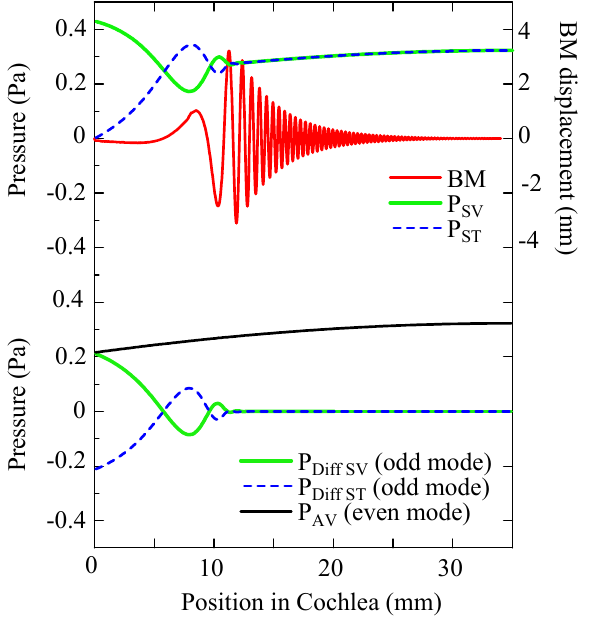
Figure 4. The upper graphs show the sound pressure levels (SPLs) in the SV ( P SV in green) and ST ( P ST in blue) and the displacement of the BM (BM in red) when a 1 Pa, 5000 Hz pure tone is applied to the OW. The lower graphs present the SPLs of the even symmetric sound mode ( P AV in black) in the SV and ST, and odd symmetric sound mode in the SV ( P Diff_SV in green) and ST ( P Diff_ST in blue). The horizontal axis shows the internal position of the cochlea, and all graphs reach the steady state ( t = 38.94 ms).